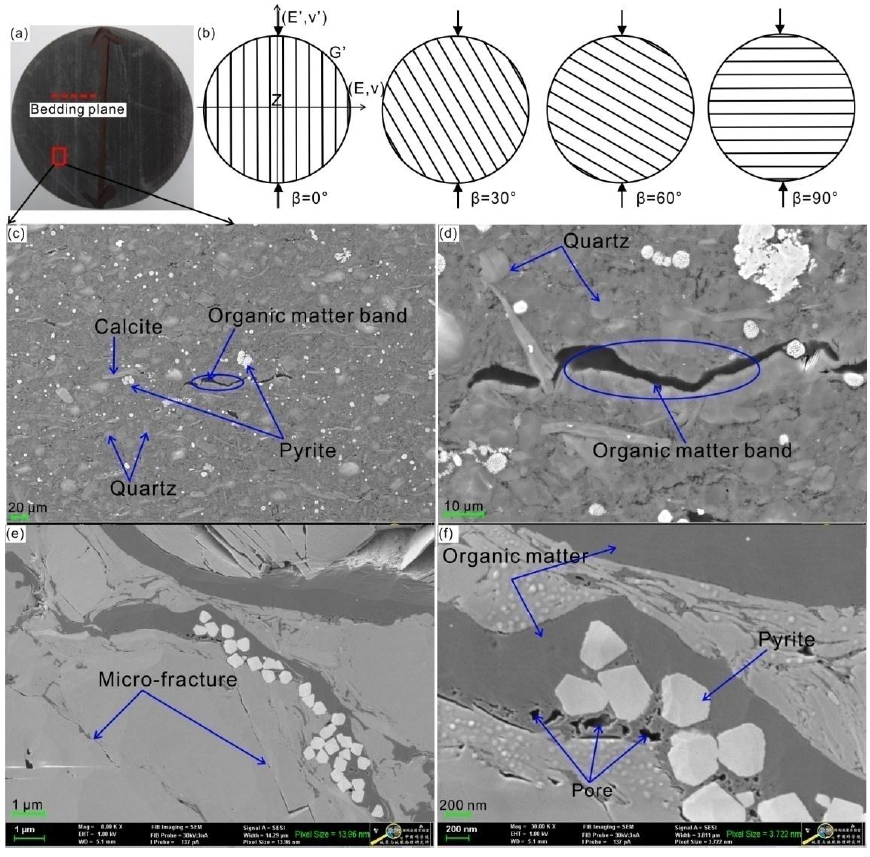
Figure 1. The internal structure of shale samples tested in this work. ( a ) Physical experimental sample; ( b ) scheme of orientation between applied force and bedding plane direction; ( c – f ) SEM results for shale sample with magnification of 2000, 4000, 8000, and 30,000 times.